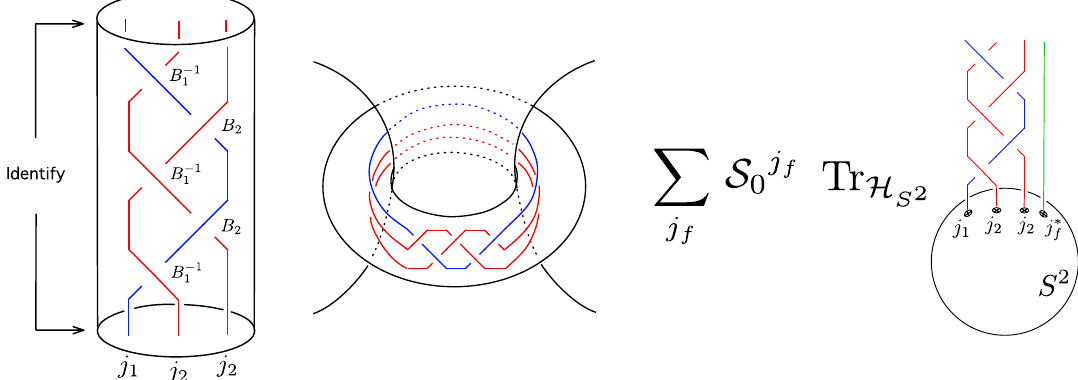
Figure 7 . (Left) The braid closure of the Whitehead link (L5a1) is imbedded in a solid torus, D 2 × S 1 . (Middle) The remaining S 3 is filled with an (empty) solid torus identified along alternative cycles. (Right) A modular S-transformation on the empty torus results in the path-integral on S 2 × S 1 , or a trace over the punctured S 2 Hilbert space. The auxiliary strand, j ∗